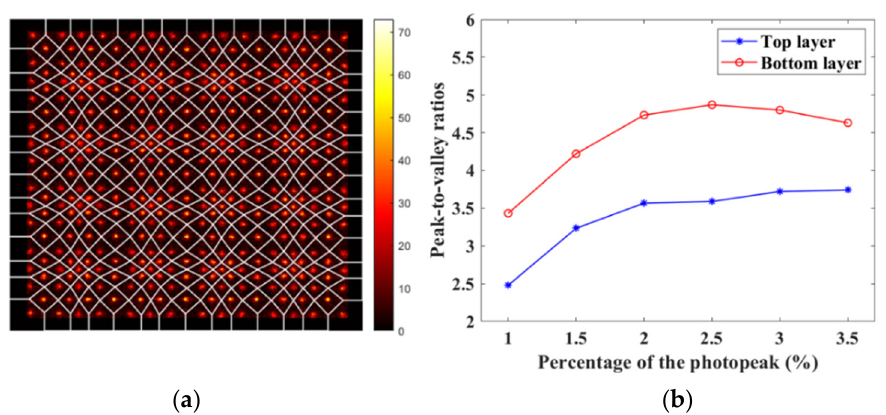
Figure 6. ( a ) Classification of the spots for the top and bottom crystals in the flood histogram of the Toray array with a threshold of 2% of the photopeak. ( b ) Plot of the peak-to-valley ratios versus the threshold (percentage of the photopeak).